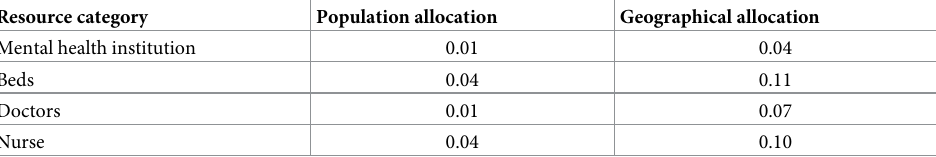
Table 6. The Theil index of resource allocation of mental health